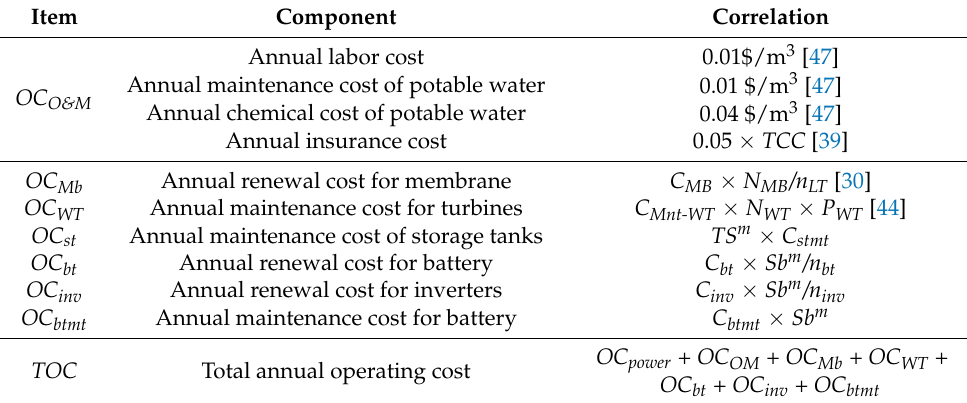
Table A2. Annual Operating Cost.